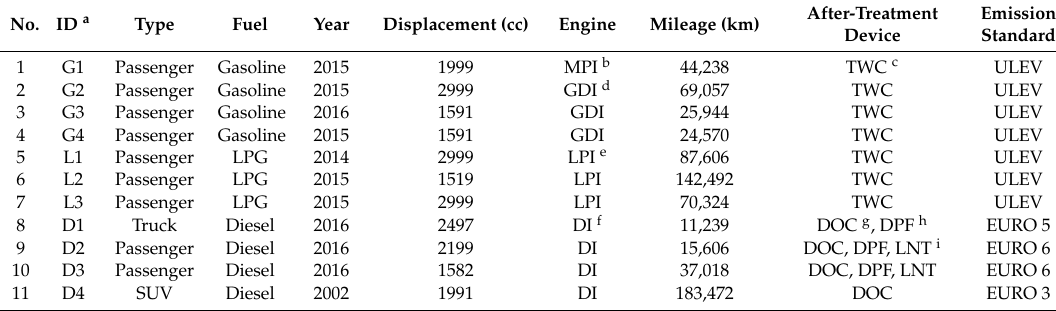
Table 2. Specifications of vehicles considered in this